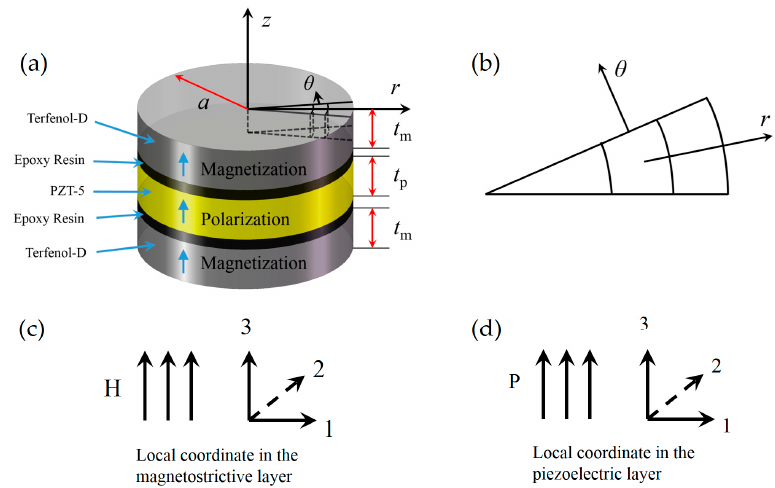
Figure 1. ( a ) The schematic of the T-T mode disk-type ME laminate composite in the cylindrical coordinate, which consists of a piezoelectric PZT-5 layer poled in its transverse direction sandwiched between two magnetostrictive Terfenol-D layers magnetized in their transverse direction. The thicknesses of the magnetostrictive and piezoelectric layer are t m and t p , respectively. Their radii are both a . The dashed volume represents a micro sector ring shaped mass unit. ( b ) The schematic of a micro sector ring shaped mass unit. ( c ) The local coordinate in the magnetostrictive layer, in which 3 denotes the magnetization direction. ( d ) The local coordinate in the piezoelectric layer, in which 3 denotes the polarization direction.